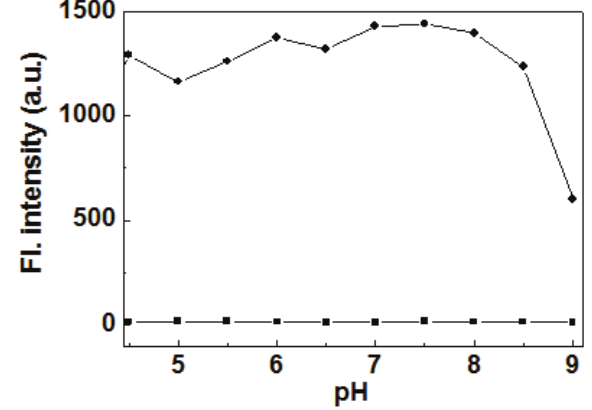
Figure 6: The fluorescence responses (at 556 nm) of free sensor Rh6G-1 (10 μM) (■) and Rh6G-1 (10 μM) + 20 equiv Fe 3+ (●) in water (containing 1 % DMSO as a cosolvent) as a function of different pH